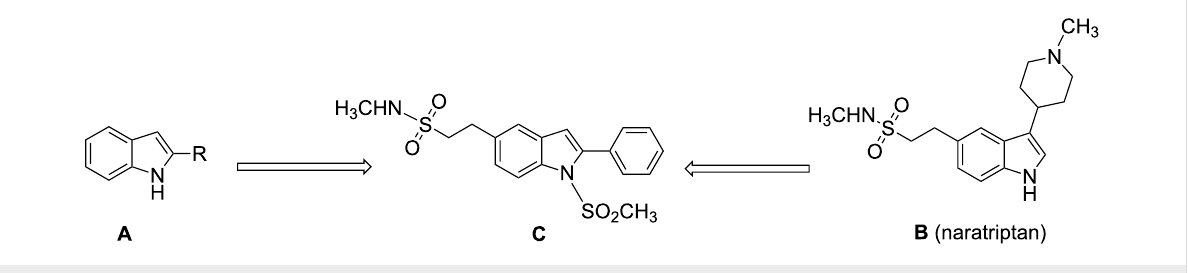
Figure 1: Design of novel indole derivative C of pharmacological interest.